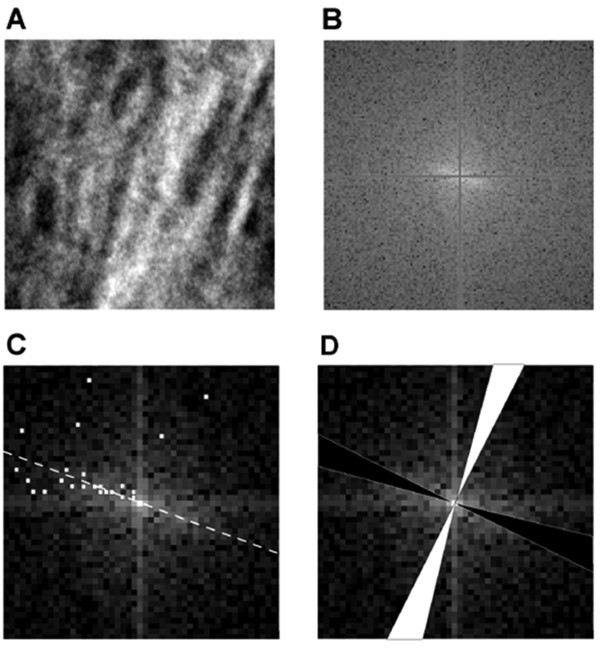
Profile generation. (A) Shows a typical region of interest (contrast enhanced for visualisation) showing the trabecular bone structure, in this case aligned approximately 22° to the vertical. (B) The central section of the FFT (128 × 128 pixels). The horizontal and vertical axes have been marked with a mid-grey tone to indicate that they have been excluded from the angle calculation. The bright strip at the centre (running from top left to bottom right) shows the preferred orientation of the trabeculae. Angles calculated from the Fourier power spectrum correspond to the same angles in the spatial domain, rotated by 90°. (C) The pixels with the maximum values are marked using white squares for the first 25 spatial frequency values of the Fourier power spectrum. The median angle, lying 21.8° from the horizontal is shown by a dashed white line. (D)_The regions used to generate the parallel (shaded black) and perpendicular (shaded white) profiles, based on the orientation of the trabecular structure.